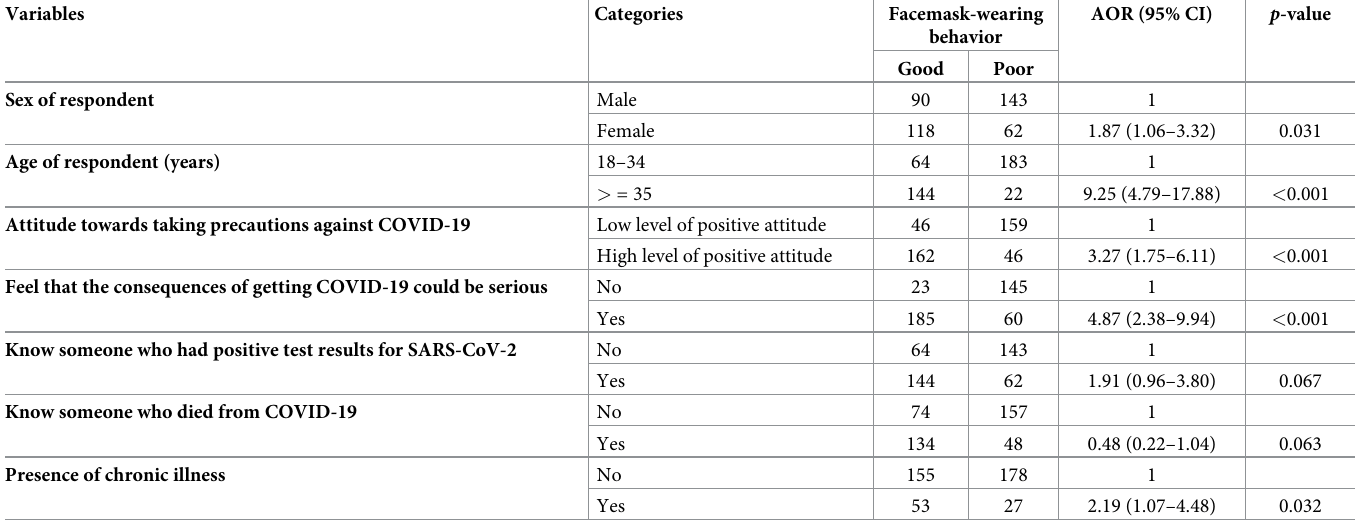
Table 6. Factors associated with facemask-wearing behavior from multivariable logistic regression analysis among bank workers in Dessie City, Ethiopia, January 2021.